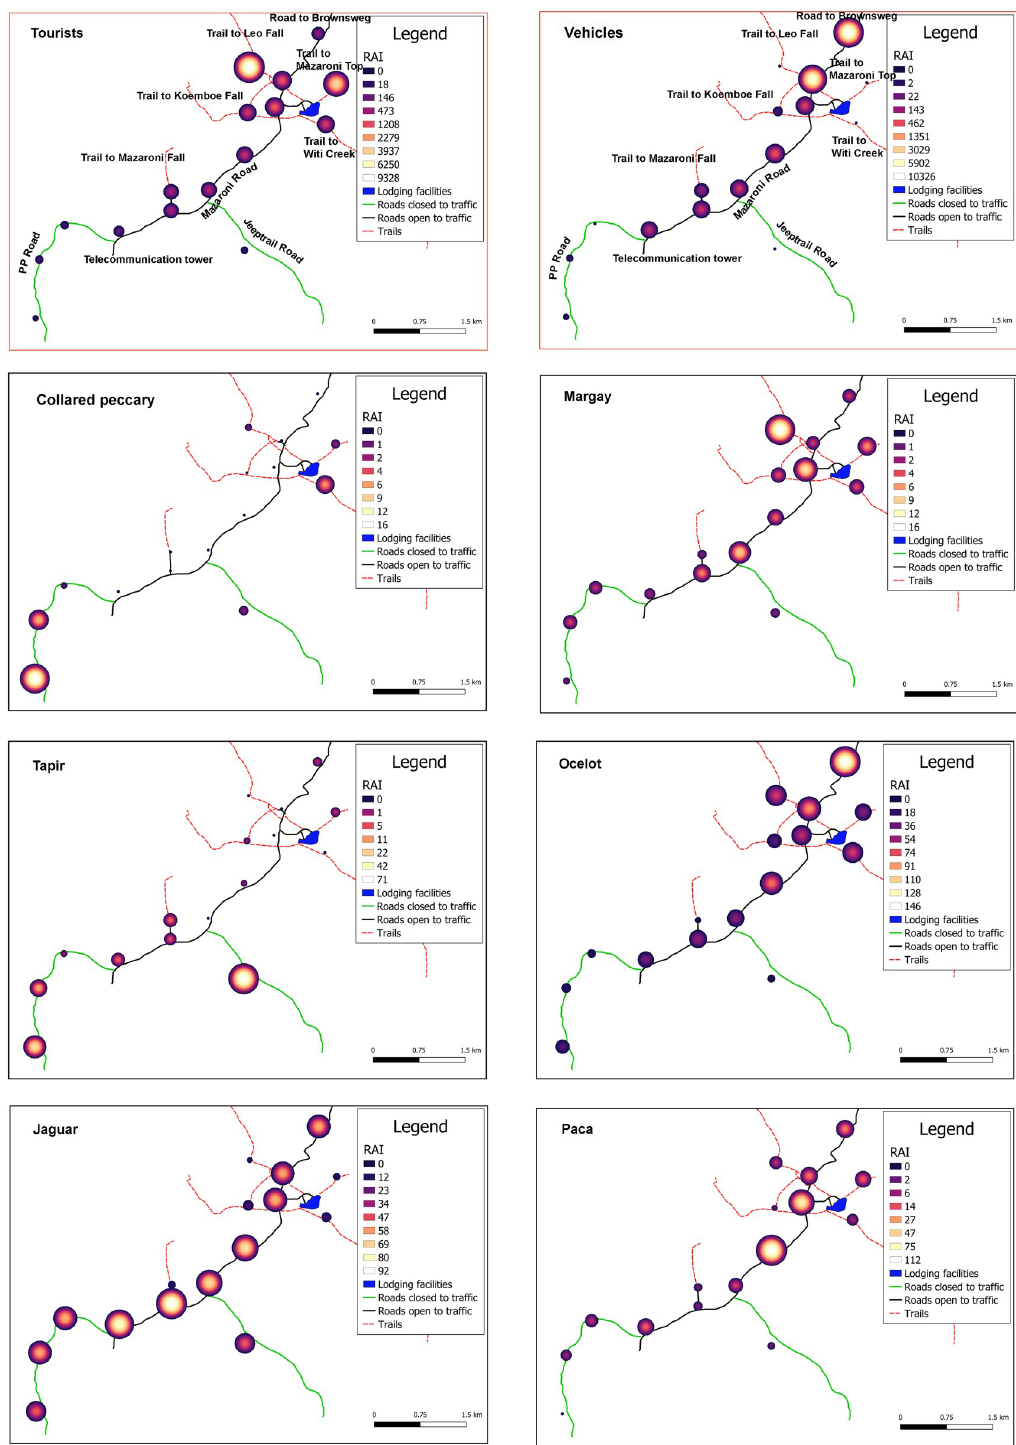
Fig 5. Heat maps with red borders indicating disturbances (hikers and traffic) and heat maps with black borders indicating species. Negatively impacted species on the left, positively impacted species on the right. RAI—relative abundance index is displayed as number of triggers per 1,000 trap days for better visualization. Roads, trails and lodging facilities were mapped by the authors. Maps were created in QGIS.